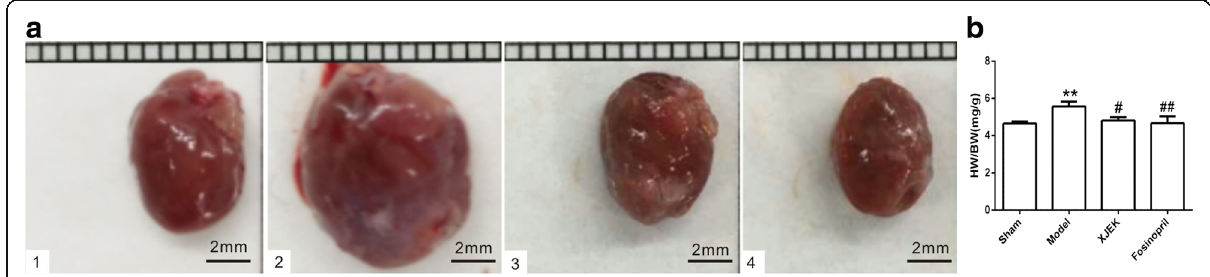
Fig. 2 Effect of XJEK on HW/BW of MI mice. a Representative figure of heart macroscopic images; b Statistic results (mean ± SEM, n = 6 – 9). (1)Sham group; (2) Model group; (3) XJEK group; (4) Fosinopril group. * P < 0.05, ** P < 0.01 vs.Sham group; # P < 0.05, ## P < 0.01 vs.Model